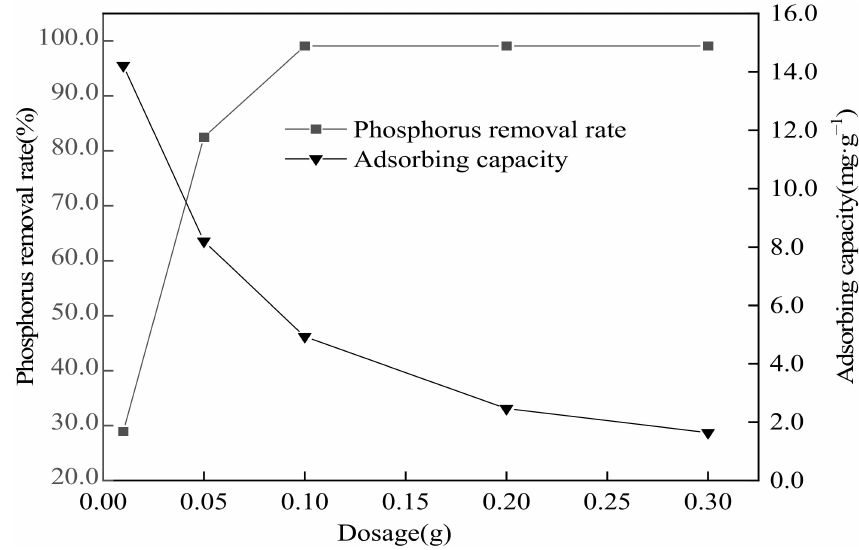
Figure 7. Effect of adsorbent dosage on phosphorus removal